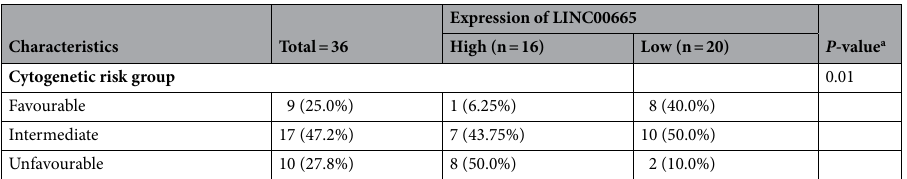
Table 3. Correlation between LINC00665 expression and cytogenetic risk of 36 cases with acute myeloid leukemia patients. a P -value indicates the significance for the comparison between higher and